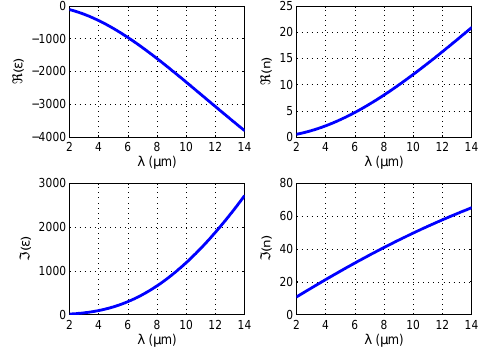
Figure 2: Real (left-top) and imaginary (left-bottom) parts of the permittivity given by Eq. (3), as well as the real (right-top) and imaginary (right-bottom) parts of the cor- responding refractive index.